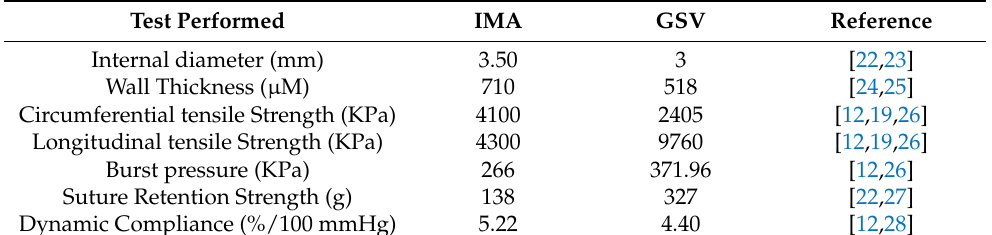
Table 1. Mechanical properties in blood vessels: internal mammary artery (IMA) and great saphe- nous vein (GSV). Test Performed IMA GSV Reference Internal diameter (mm) 3.50 Wall Thickness (µM) Circumferential tensile Strength (KPa) Longitudinal tensile Strength (KPa)